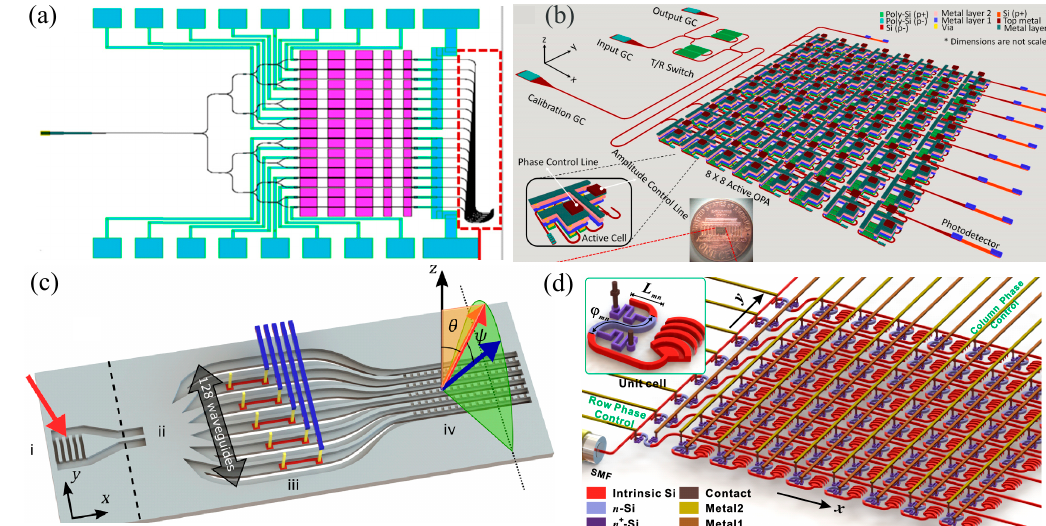
Figure 10. Typical OPA structures based on the Si platform. ( a ) The structure of an OPA chip with a plateau envelope. Reprinted with permission from [59] © The Optical Society. ( b ) An 8 × 8 monolithic OPA. Reprinted with permission from [86] © The Optical Society. ( c ) A 1D aperiodic high-resolution aliasing-free OPA. Reprinted with permission from [12] © The Optical Society. ( d ) A 2D aperiodic Si-based OPA with independently tunable phase shifters. Reprinted with permission from [87] © The Optical Society.